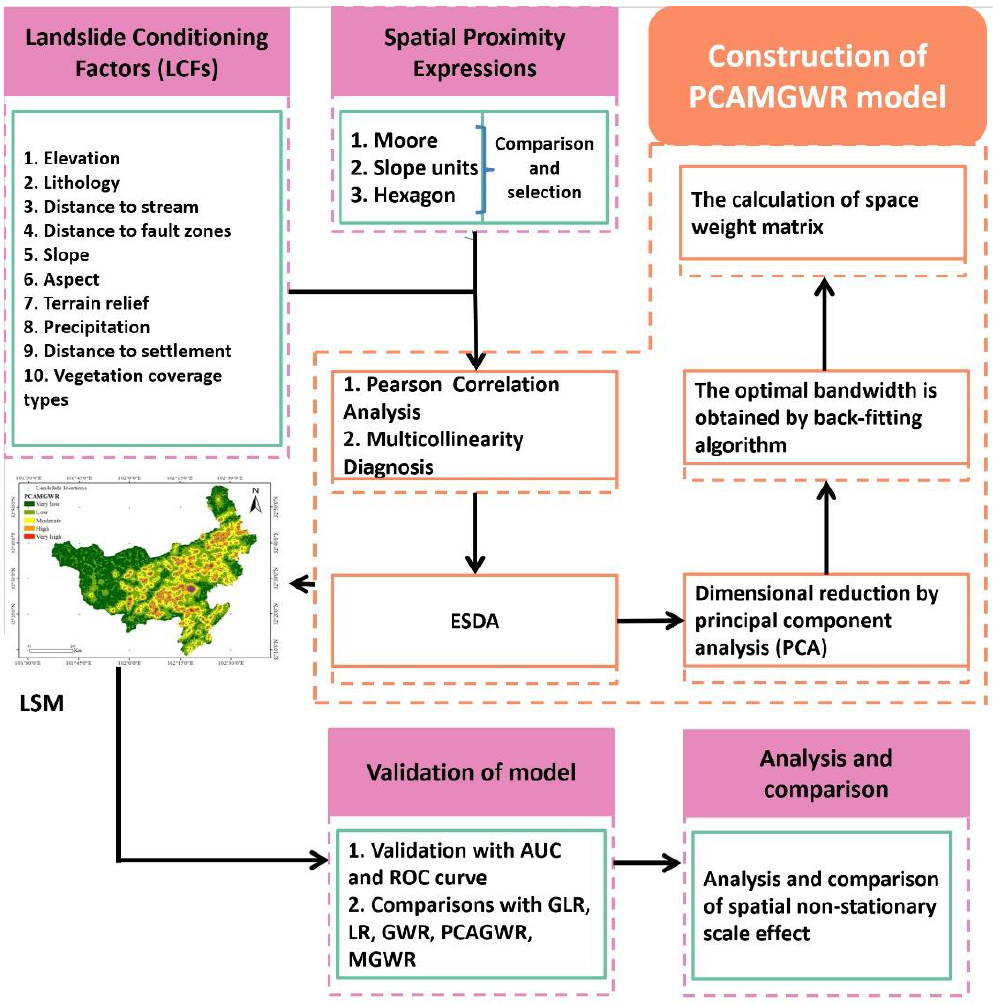
Figure 3. Methodology of research applied in this study.